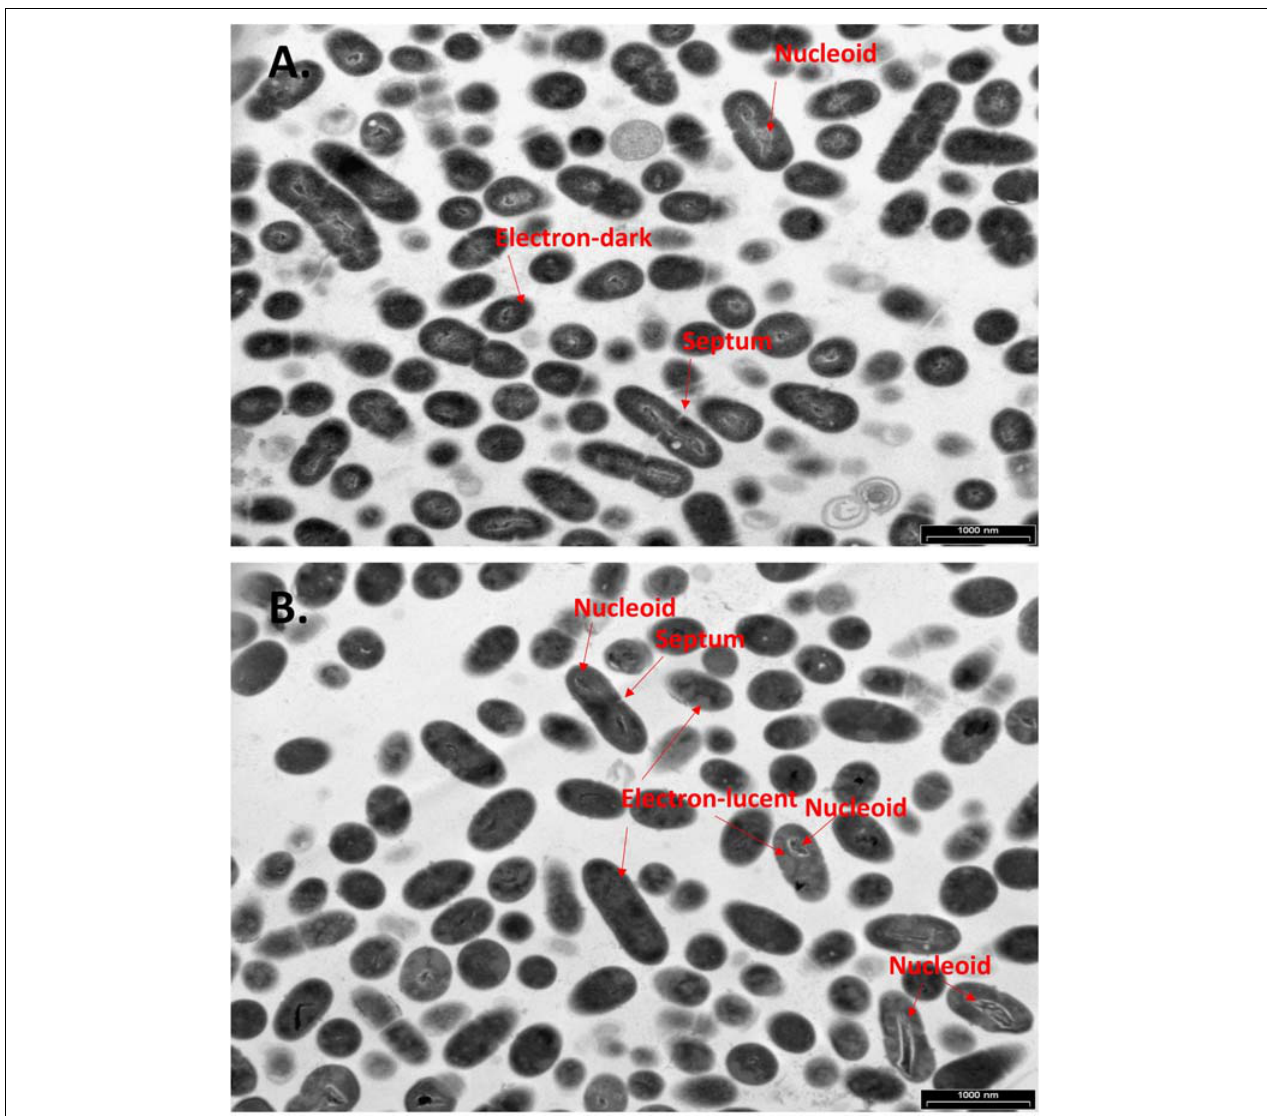
FIGURE 3 | CBG alters the morphology of S. mutans. (A,B) Panoramic TEM images (x9700) of control (A) and 4 h CBG (10 µ g/ml)-treated (B) bacteria. The arrows point to the nucleoids, the electron-dense and electron-lucent areas, and the invagination septum in control and CBG-treated S. mutans